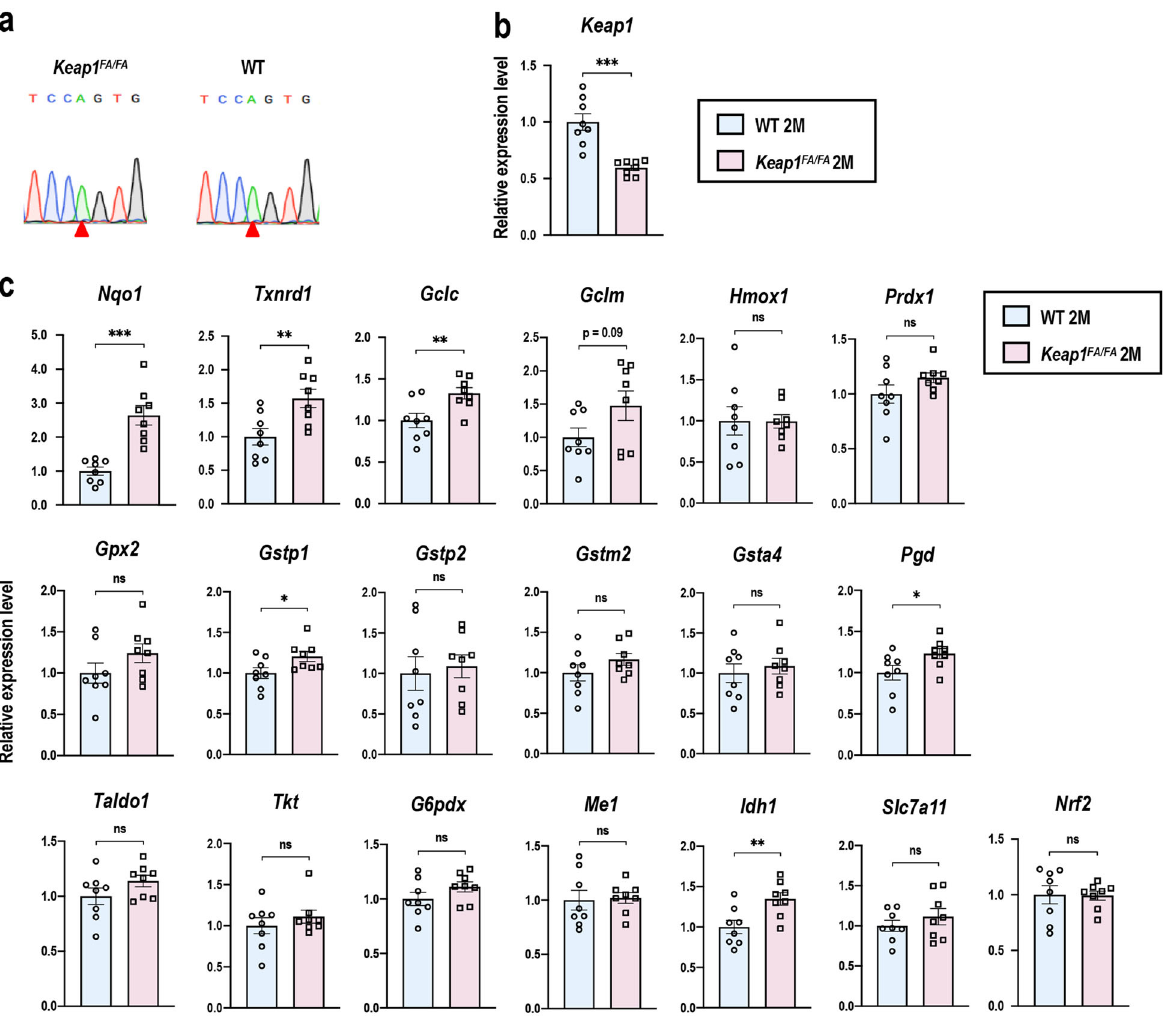
Fig. 4 Gene expression in cochleae of the WT and Keap1 FA/FA mice at 2 months of age. a Detection of an SNP in the Cdh23 gene ( n = 6 in each group). Red arrowheads indicate the SNP of the Cdh23 753A allele. Expression levels of Keap1 ( b ) and NRF2 target genes and Nrf2 ( c ) in the whole cochleae were measured by quantitative real-time PCR ( n = 8 in each group). All the samples were quanti fi ed by using the same standard curve and each expression level was normalized to Hprt expression. Average expression levels of WT cochlea are set as 1. Data represent the mean ± SEM. * P < 0.05, ** P < 0.01, *** P < 0.001. Unpaired two-tailed Student ’ s t -test was applied. A part of data on the WT mice at 2 months of age are the same as those shown in Fig.